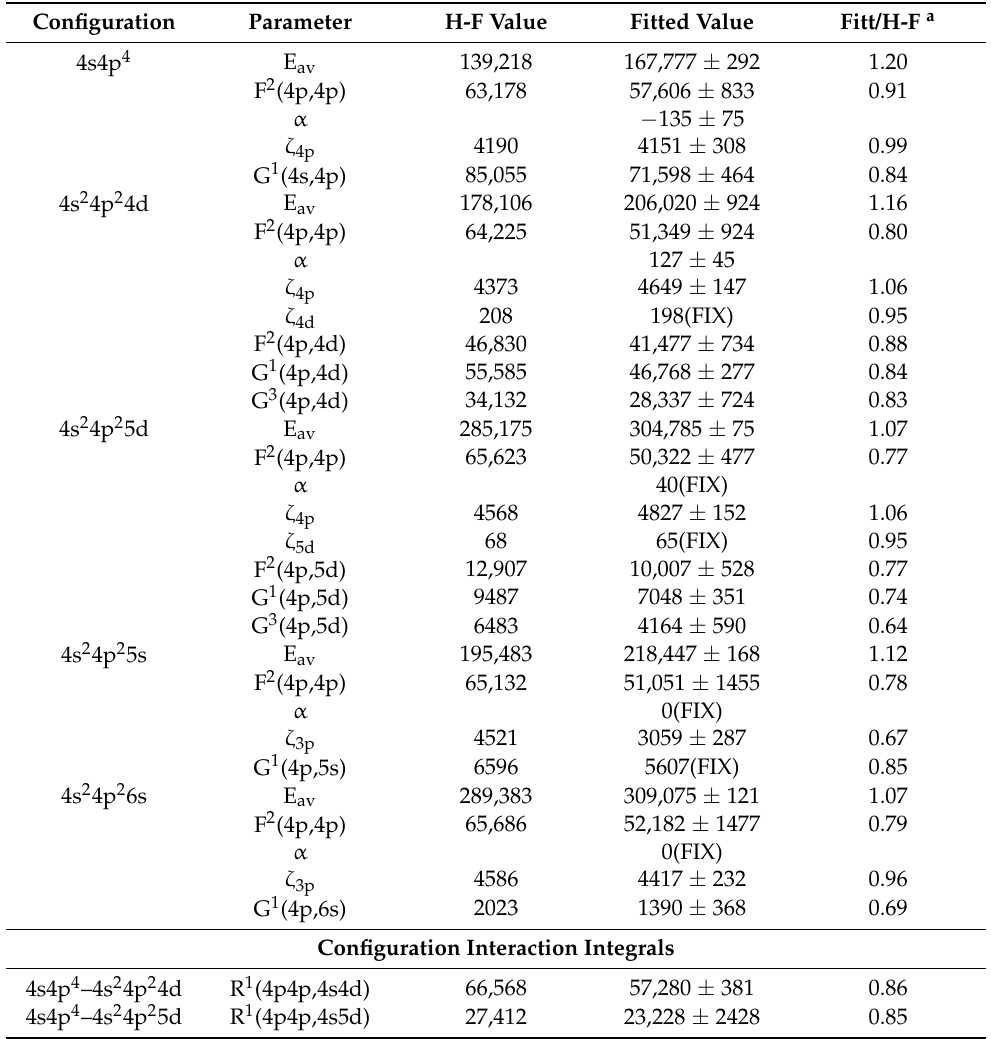
a Parameters omitted from this table: direct and exchange integrals and spin-orbit ζ parameters set to 85% and 95% of their HFR values respectively; CI integrals were set to 85% of their HFR values. The standard deviation for the energy adjustment was 266 cm − 1